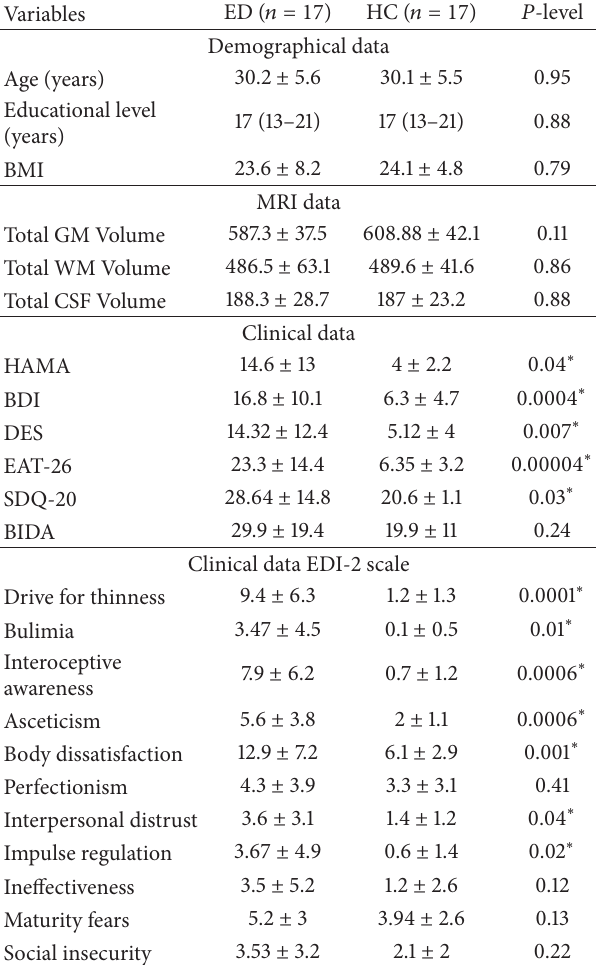
Table 1: Demographic